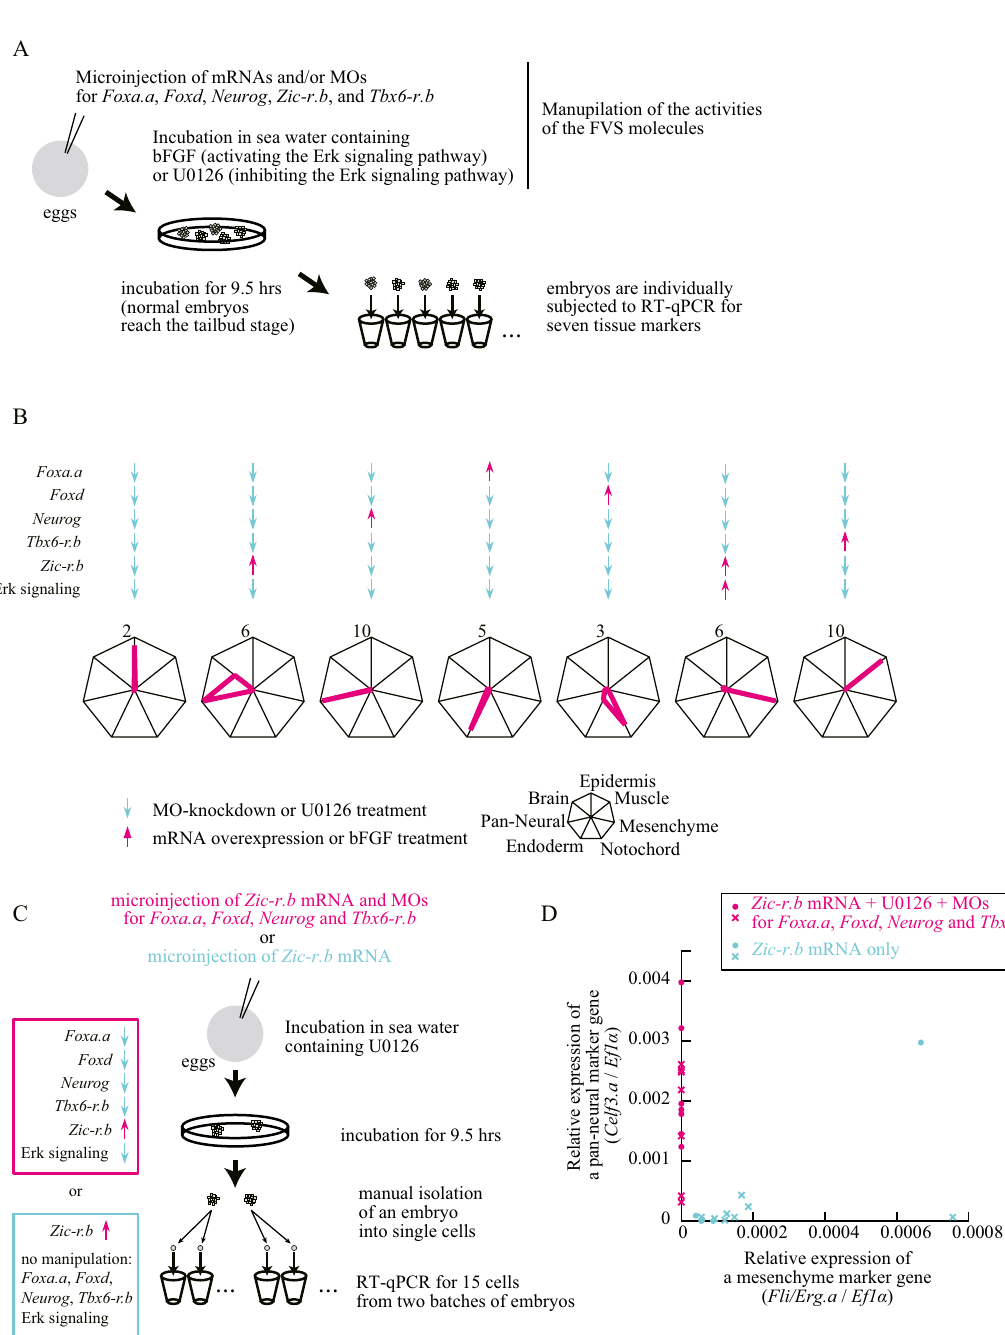
Figure 4. Reprograming of cell fate by manipulating activities of FVS factors under a multi-cellular condition. ( A ) The experimental design for cell fate control under a multi-cellular condition. ( B ) FVS factors are up- or down-regulated in seven different combinations as shown at the top. Radar graphs show expression levels of marker genes relative to their corresponding values in normal 9.5-h (tailbud) embryos in the seven experimental conditions. Each axis shows expression of a tissue marker, as shown at the bottom. Mean values for 12 embryos from two batches (six from each) are shown. Values for individual embryos are shown in Fig. 5. ( C , D ) Relative expression levels of the pan-neural ( Celf3.a ) and mesenchyme ( Fli/Erg.a ) markers to the expression level of Ef1α in individual cells in two conditions (magenta and cyan). The experimental design is shown in ( C ). In ( D ), cells from different batches are shown by circles and